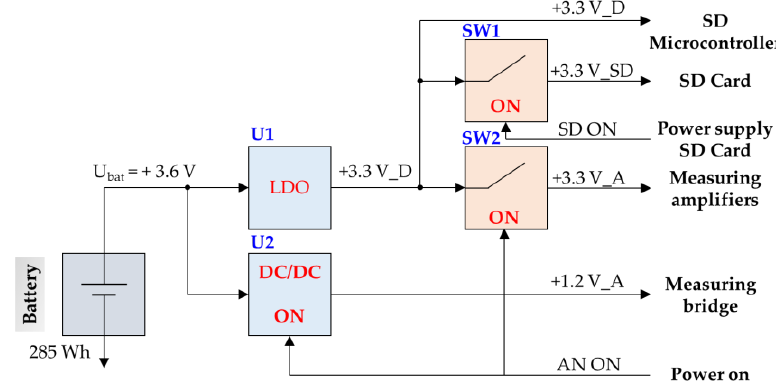
Figure 6. Power scheme of the recording system.